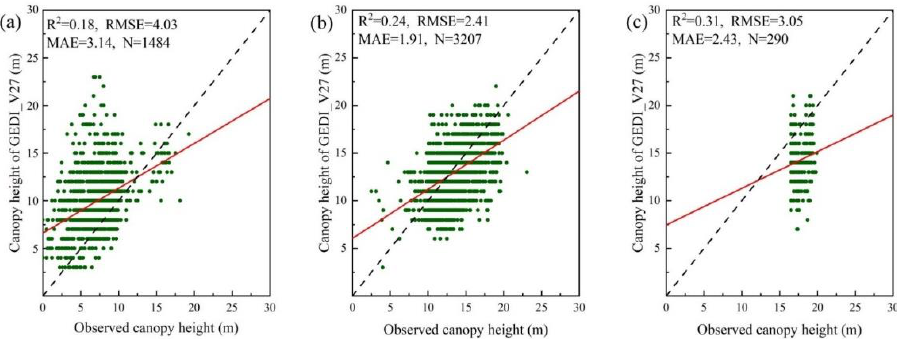
Figure 15. Canopy height accuracy for the three age groups of the GEDI_V27. ( a ) Young stands (0–10 years). ( b ) Middle-aged stands (10–20 years). ( c ) Mature stands (more than 20 years).